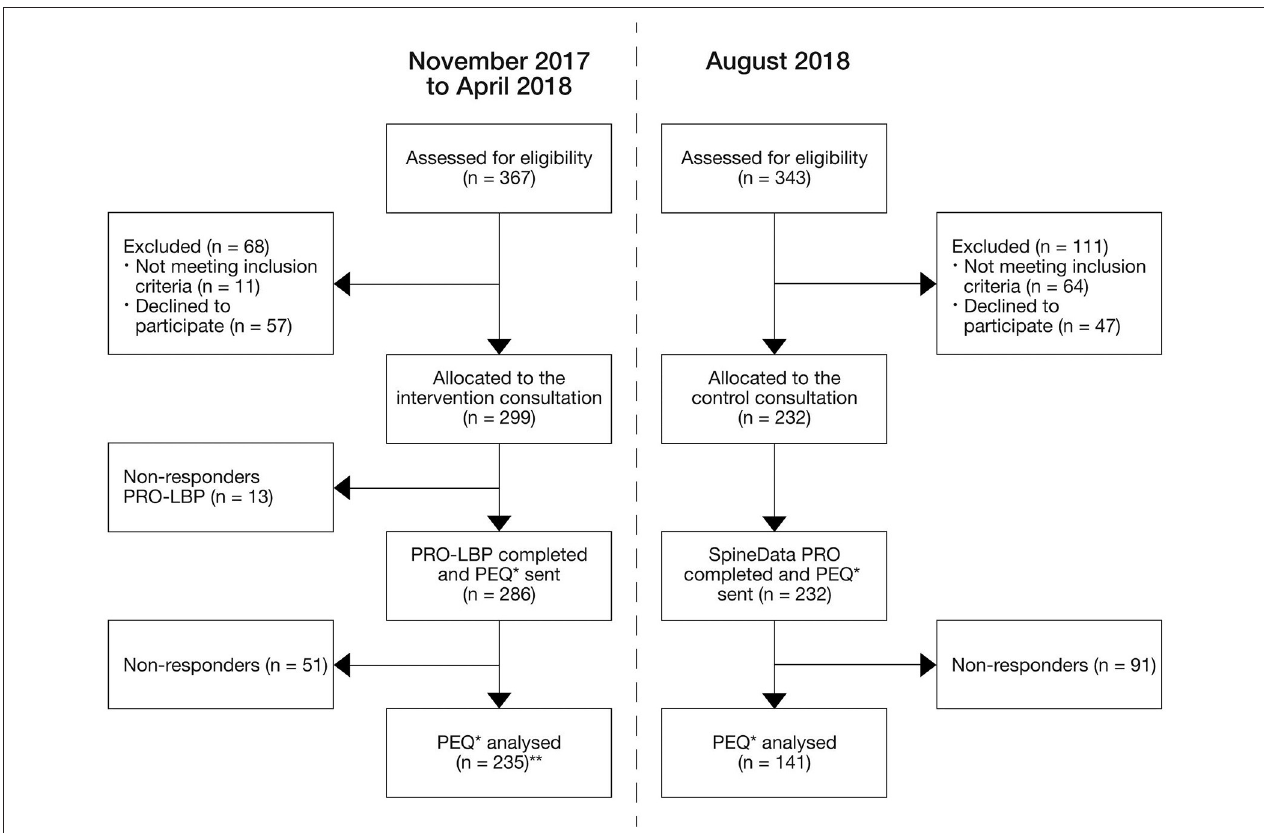
FIGURE 3 | Study flowchart. *PEQ, Patient evaluation questionnaire; **Data regarding the item “use of the patient profile LBP in the consultation” were missed in 4 patients due to technical issues, thus analysis were based on 231 patients.